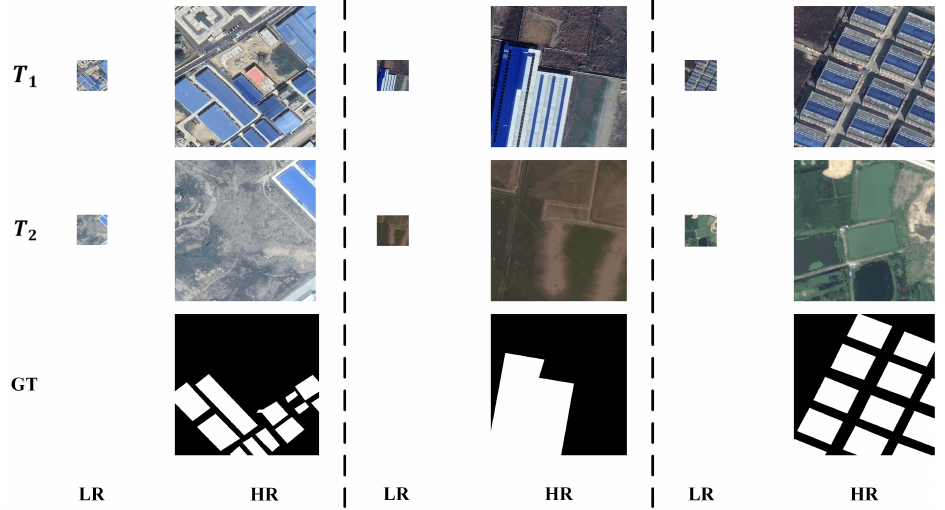
Figure 8. Example images of the